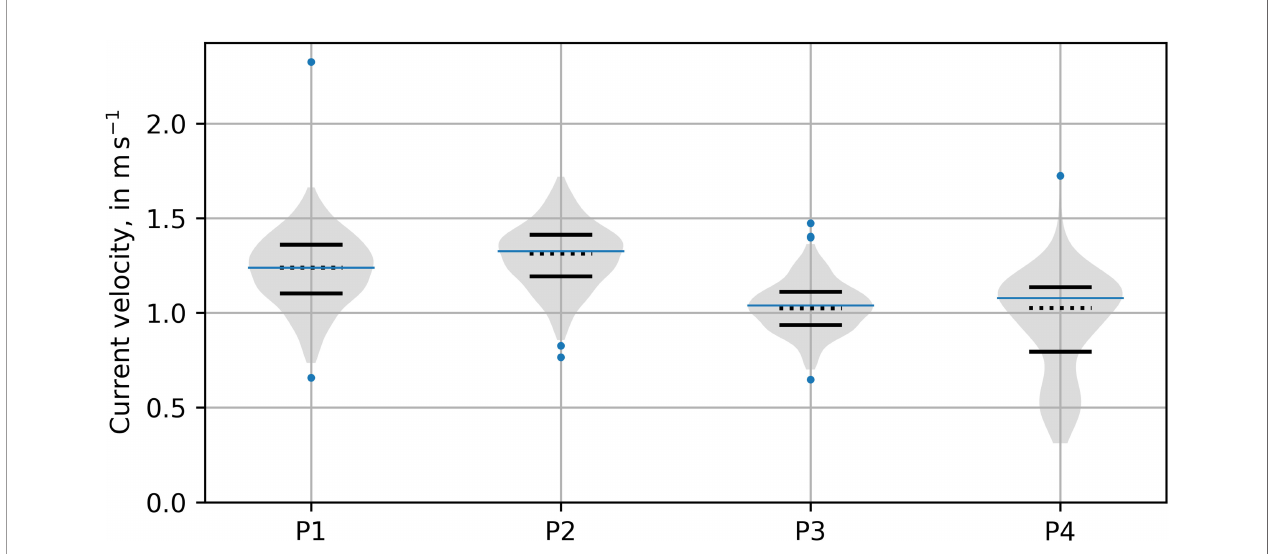
FIGURE 9 | Detected outliers and distribution of peaks for nodes at P1 to P4. The fi rst and third quartiles are shown as solid lines and the median as a dotted line. The fi ltered outliers are shown as blue dots and the selected threshold as a thin blue